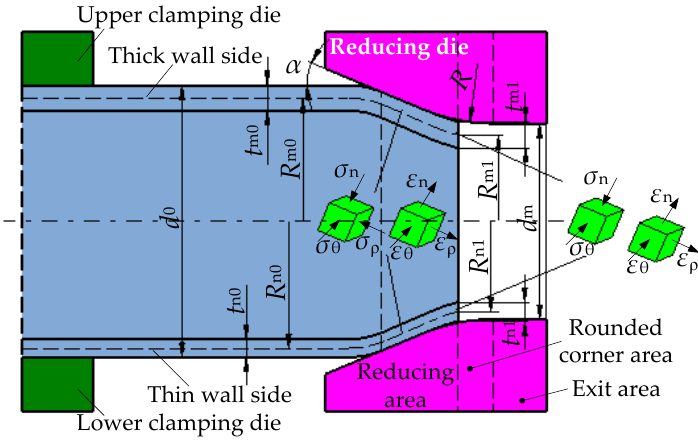
Figure 6. Reducing stage.